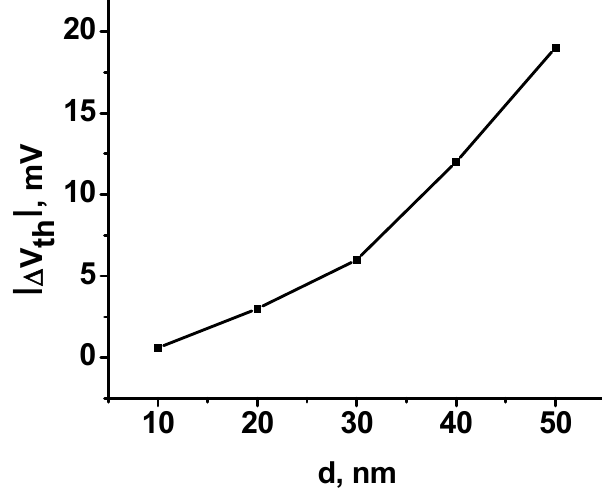
Figure 1. Dependence of the threshold voltage change on the linear size of charged area.